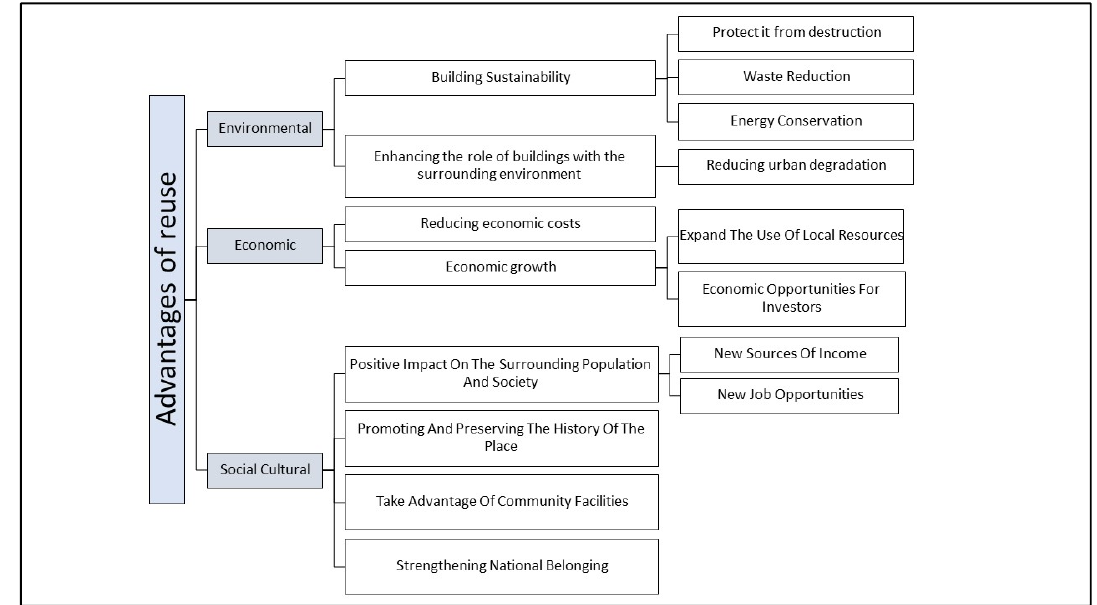
Figure 1. Advantages of adaptive reuse .